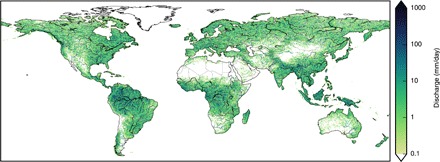
Mean daily discharge (historic period, 1971 to 2004).Median over the ensemble of all 50 combinations of 10 hydrological and 5 climate models. Their runoff output was routed by the river routing model CaMa-Flood (12) to derive their mean daily discharge in the historic period; plotted here is the median of all model combinations. Very dry cells (discharge, <0.1 mm/day) are masked (white); this mask is also used for the other figures.